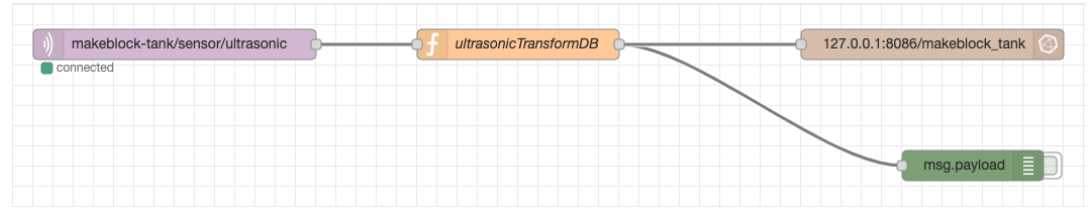
Figure 5. Connection of the input MQTT node to the output node of the InfluxDB database.